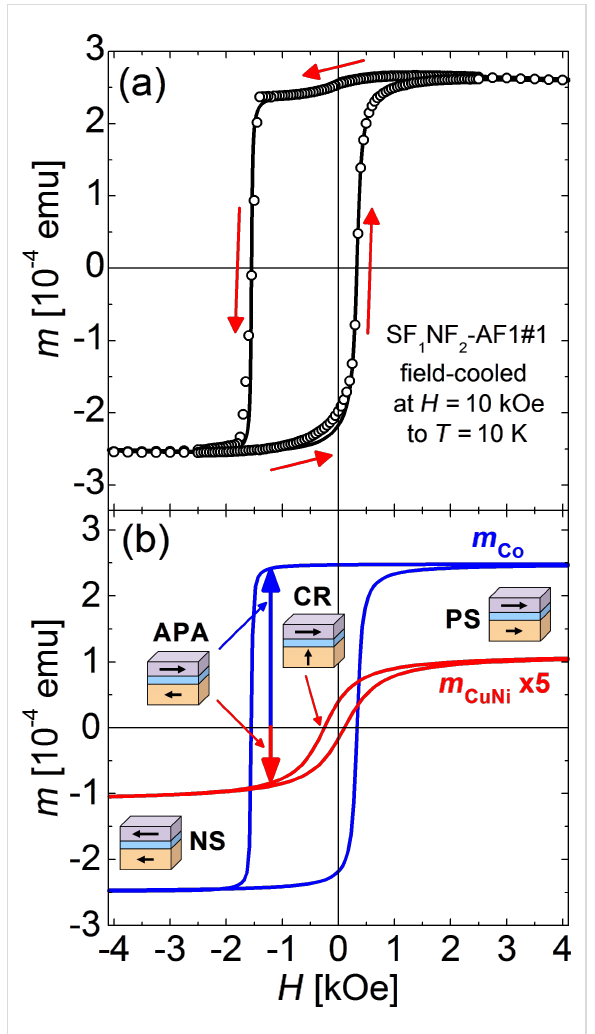
Figure 4: (a) Magnetic hysteresis loop of SF 1 NF 2 -AF1#1 recorded by a SQUID magnetometer. Here, m is the magnetic moment and H the magnetic field applied parallel to the film plane. The solid line shows a reconstruction of the hysteresis loop according to the simple version of the model of Geiler and co-workers [62]. The corresponding parame- ters are summarized in Table 2. The sample was cooled to 10 K in a field of 10 kOe applied parallel to the film plane. The red arrows indi- cate the sweep direction. (b) Separation of the obtained hysteresis loop into the constituent loops of the individual layers according to Equation 1. The copper–nickel signal is enlarged by a factor of 5 to improve visibility. The pictograms indicate the different magnetic con- figurations of the system (PS: positive ( H > 0) saturated; NS: negative ( H < 0) saturated; APA: antiparallel alignment of the magnetic moments of the F 1 = Cu 41 Ni 59 and F 2 = Co layers; CR: crossed config- uration of the magnetic moments of F 1 - and F 2 layers). The diamag- netic contribution of the silicon substrate is subtracted (only in (b)). Here, cgs emu units are used. In SI units, it is 1 emu = 10 − 3 A·m 2 and 1 Oe = 10 3 /(4 π ) A/m [63], so that (with μ 0 = 4 π ·10 − 7 V·s/(A·m)) the magnetic flux density related to 10 kOe is B = μ 0 H = 1 T.